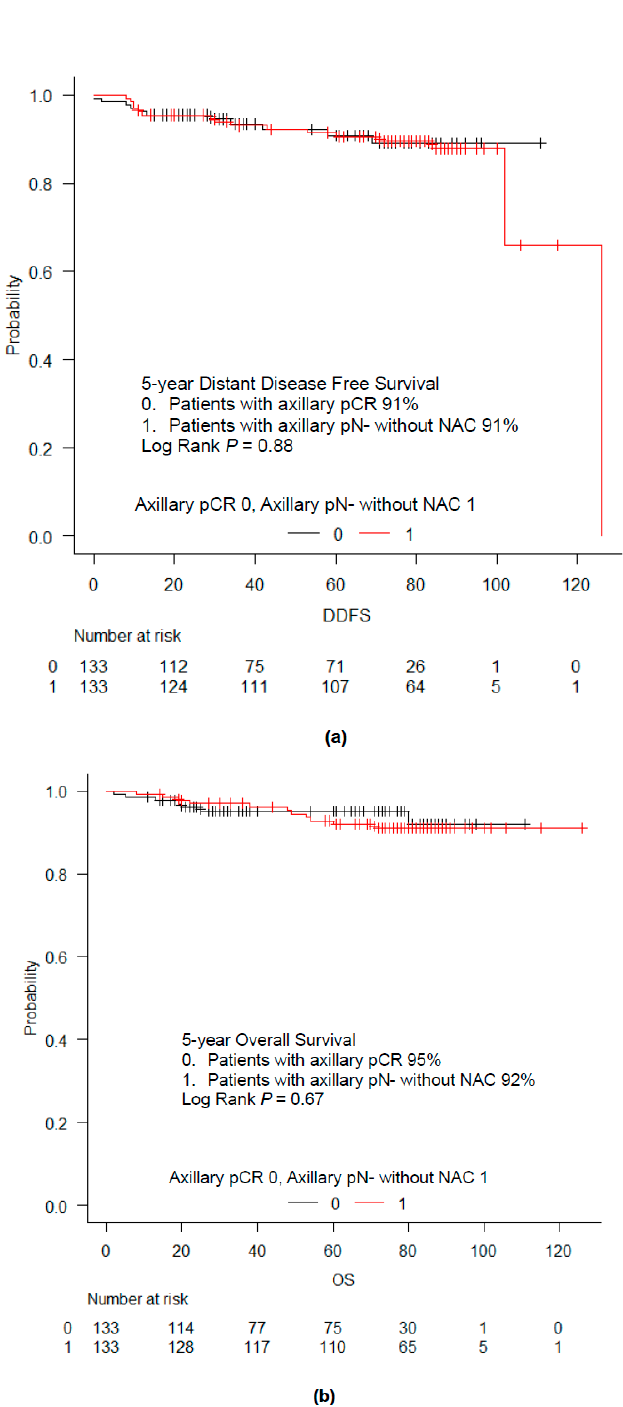
Figure 3. Survival outcomes of patients with axillary pCR and matched pairs with axillary pN- without NAC. Kaplan–Meier curves for DDFS ( a ) and OS ( b ) in patients with cytologically proven node-positive breast cancer with axillary pCR after NAC and matched pairs with axillary pN- without NAC. The log-rank test showed that there was no significant difference in DDFS and OS between patients with axillary pCR and matched pairs with axillary pN- without NAC ( p = 0.88 for DDFS; p = 0.67 for OS).